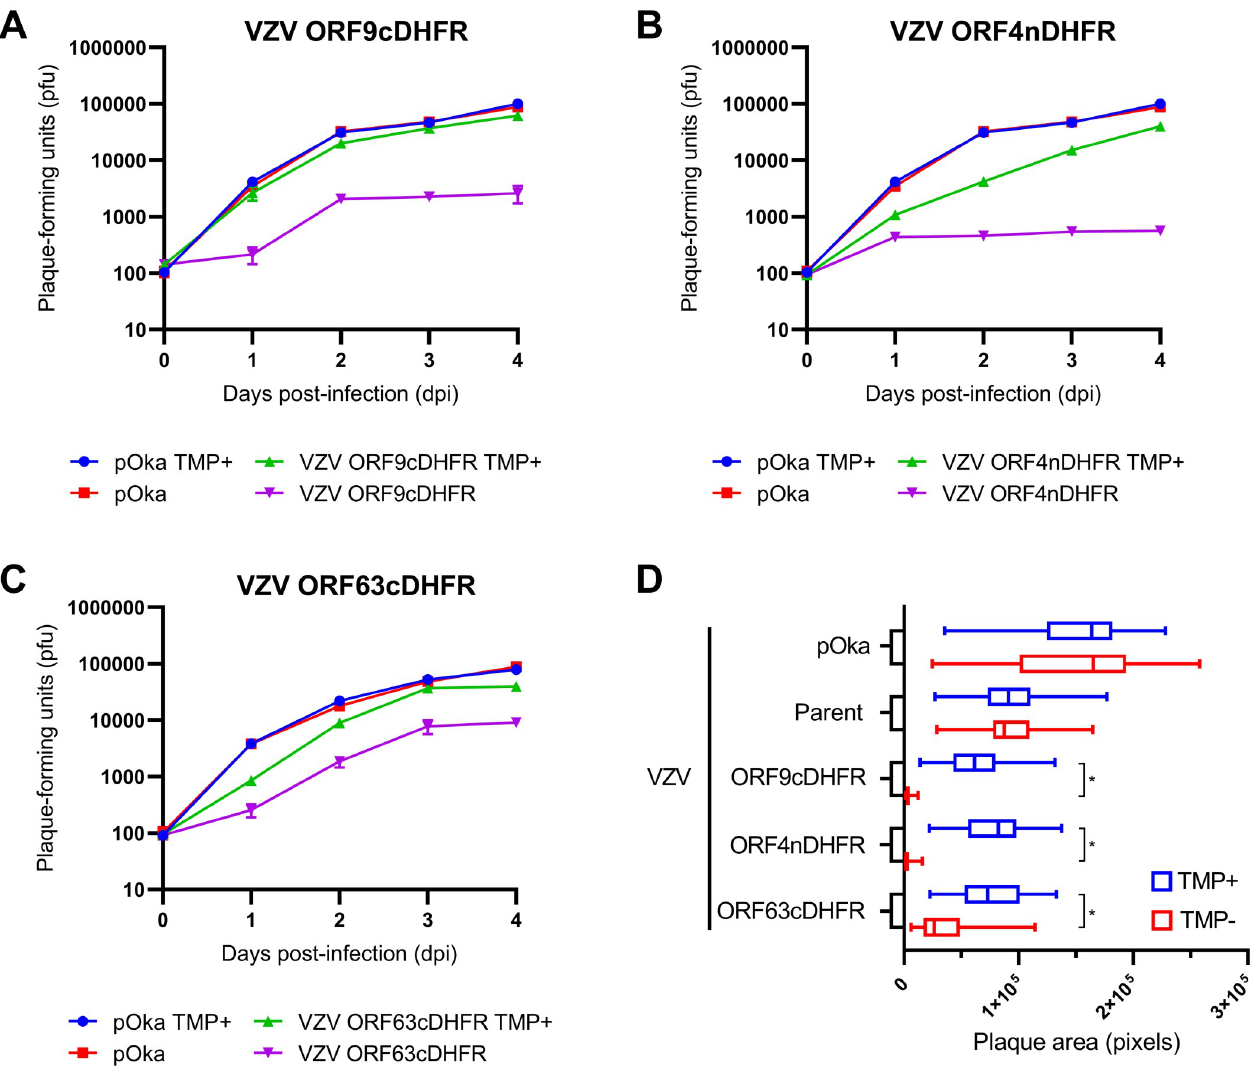
Fig 2. Growth of VZV containing DHFR degron sequence on specific genes confers TMP-conditional virus growth and formation of plaques. (A-C) Conditional growth analysis of three VZV after initiating the infection of monolayers at low multiplicity with VZV degron virus or pOka. Cultures were grown in the presence or absence of 100 nM TMP maintained throughout the growth period from 0–4 days post-infection (dpi). Each day, cultures were then trypsinized and the infectious cell titer was determined by growth on new monolayers in conditions in which TMP was provided in the media. Shown are growth analyses for (A) VZV ORF9cDHFR, (B) VZV ORF4nDHFR, and (C) VZV ORF63cDHFR. (D) Plaque size of wild-type VZV (pOka) or VZV derived from the parental BAC (parent) or containing the degron addition to the respective genes compared under permissive (100 nM TMP, blue) or nonpermissive (0 nM TMP, red) conditions at 4-dpi. Images (n = 28–35) were acquired for each virus/condition under identical settings and evaluated as detailed in methods and presented in pixel size estimated from images acquired under 10X (NA.030) air objective. Error bars: SD. VZV genes in frame within the virus. The DHFR degron facilitates protein turnover unless it is stabilized by the cell-permeable ligand TMP (Fig 1A). In the absence of TMP, the protein is turned over as a result of ubiquitin binding to the degron, which initiates proteasome-medi- ated turnover of the fused protein (Fig 1B). The system overcame the need to generate comple- menting cells and was successfully exploited to show that ORF63 protein is essential for SVV growth [64]. Unexpectedly, VZV with the degron fused to ORF62 (with concurrent deletion of the reiterated ORF71) encoding the major transcriptional regulator protein IE62 were found